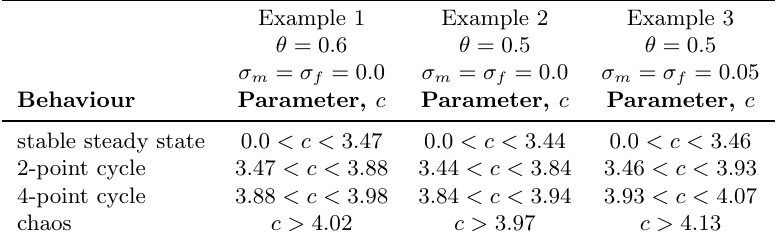
Table 1: Approximate bifurcation positions for both male and female populations of (3), using equations (5) and (6).